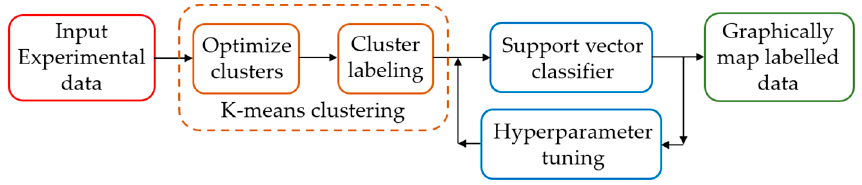
Figure 1. An overview of the methodology for creating tribocorrosion maps.